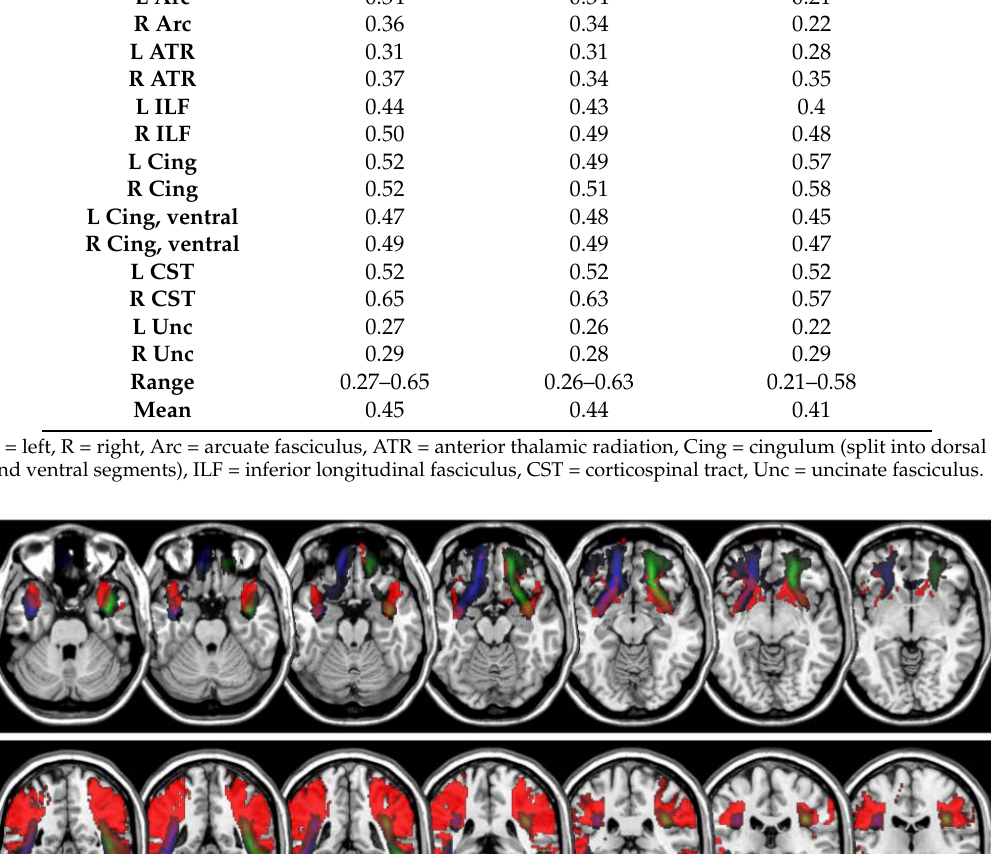
Figure 5. Overlays of the uncinate ( a ) and arcuate ( b ) fasciculi. Atlas tracts represented in red (from [17]) and tracts segmented in the LBC1936 data using atlas-based reference tracts and unsupervised models in green ( left ) and blue ( right ), in radiological convention.